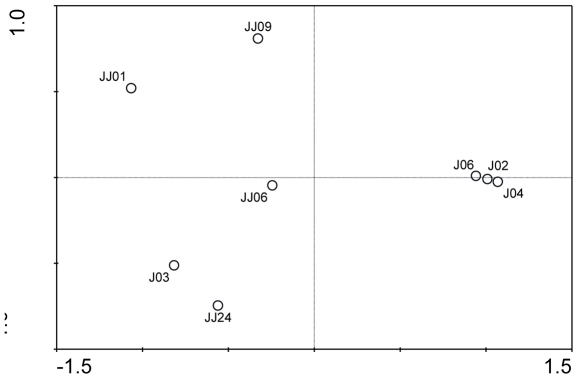
PCA ordination diagram of the anammox communities calculated using 16S rRNA gene sequences from Jiaojiang estuarine sediments.